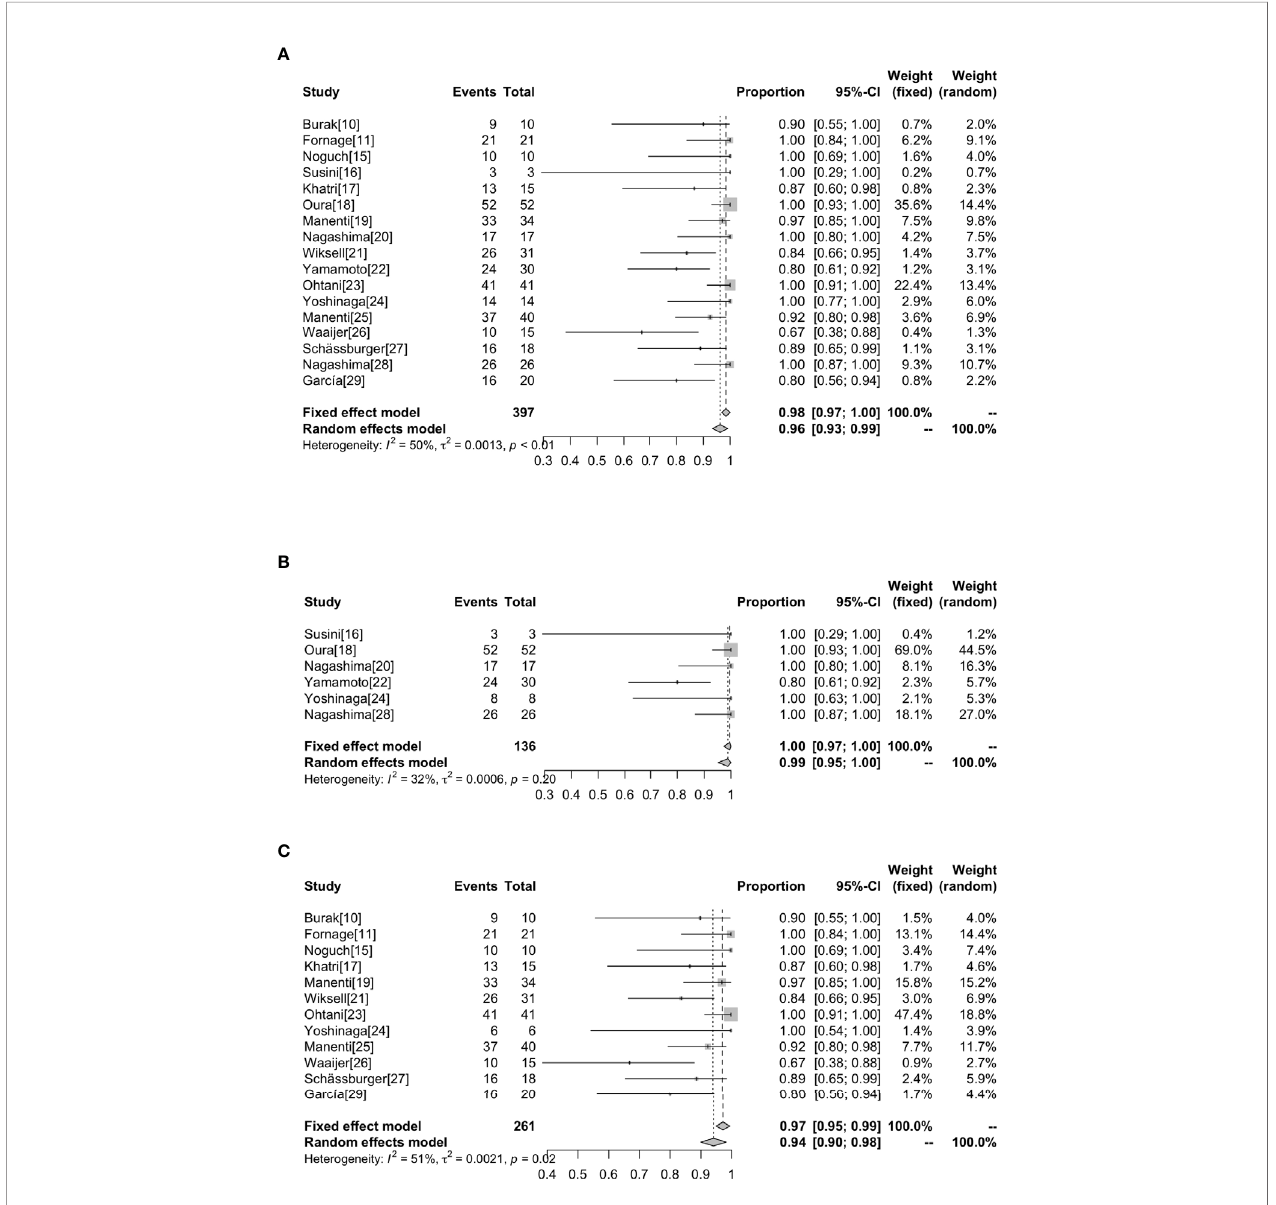
FIGURE 3 | Forest plot showing the analysis of complete ablation rate in patients receiving RFA. The results of all the patients (A) , patients without surgical resection following RFA (B) , patients with surgical resection following RFA (C) are shown,